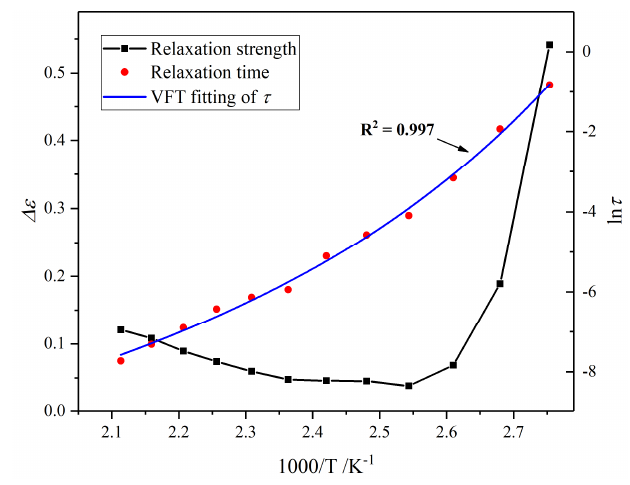
Figure 10. HN-equation fitting results of thermionic polarization of pure epoxy resin from 90 °C to 200 °C.